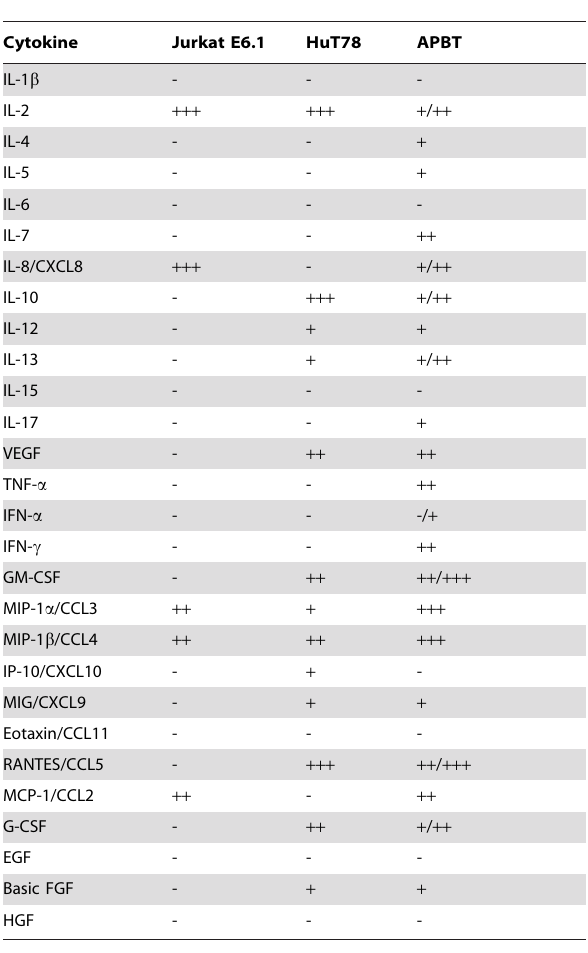
Table 1. TCR-induced release of cytokines and chemokines from Jurkat E6.1 T cells, HuT78 T cell, and